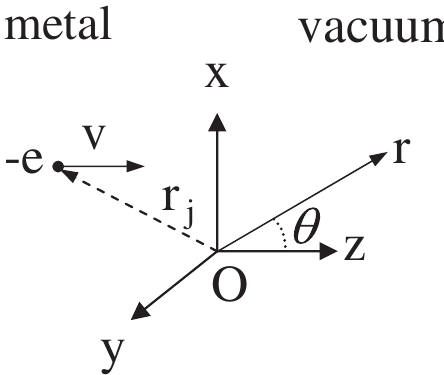
, z . The half-space z < j